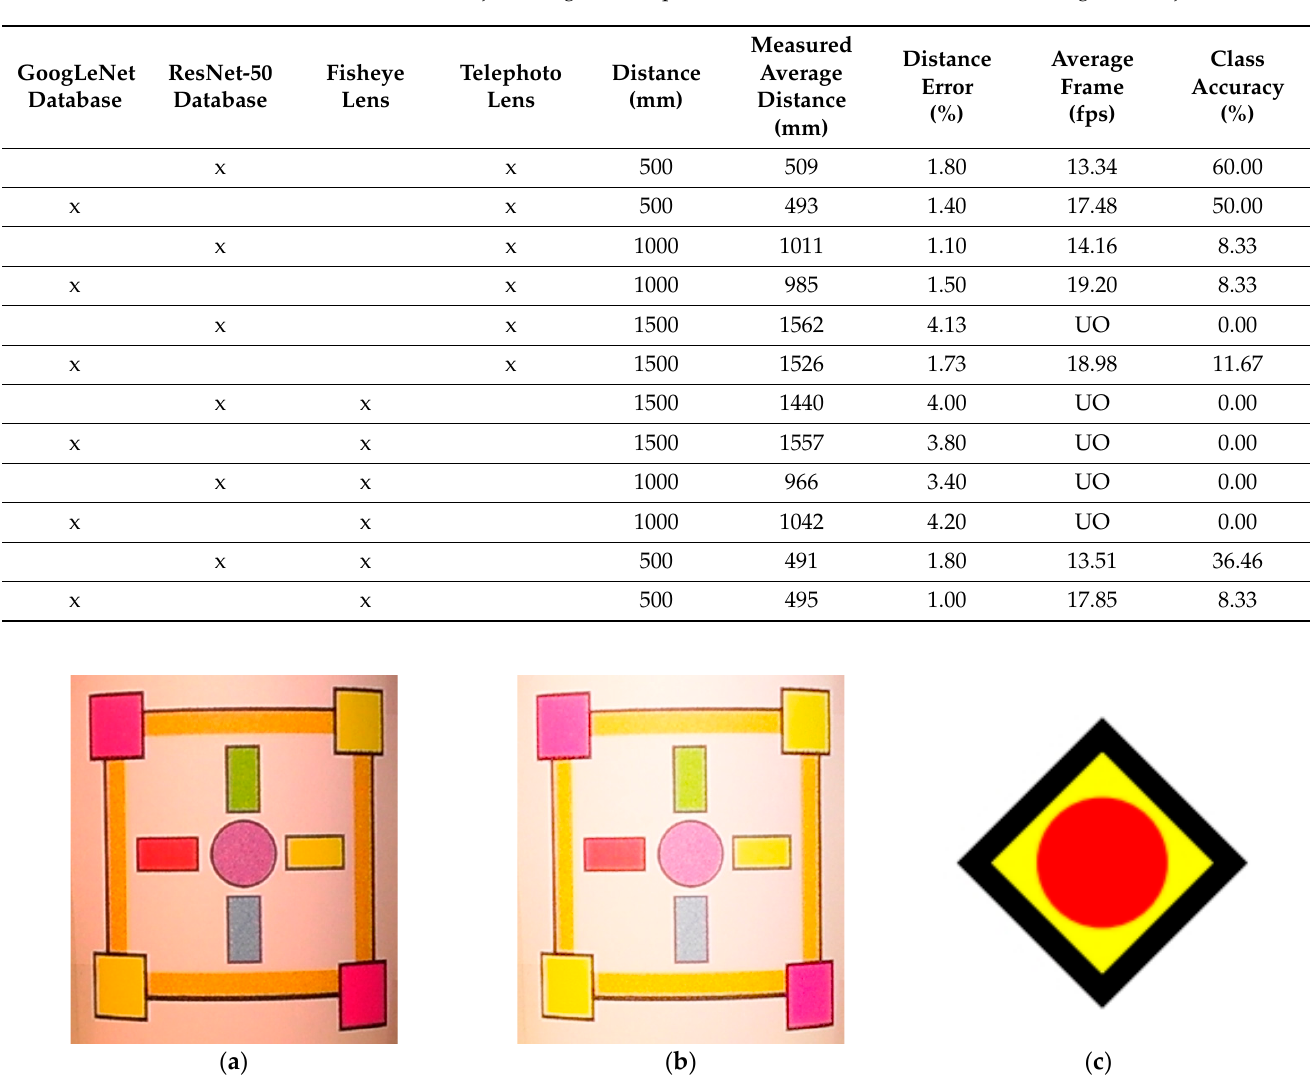
Table 2. Test object recognition experimental research results. (UO = unrecognized object).